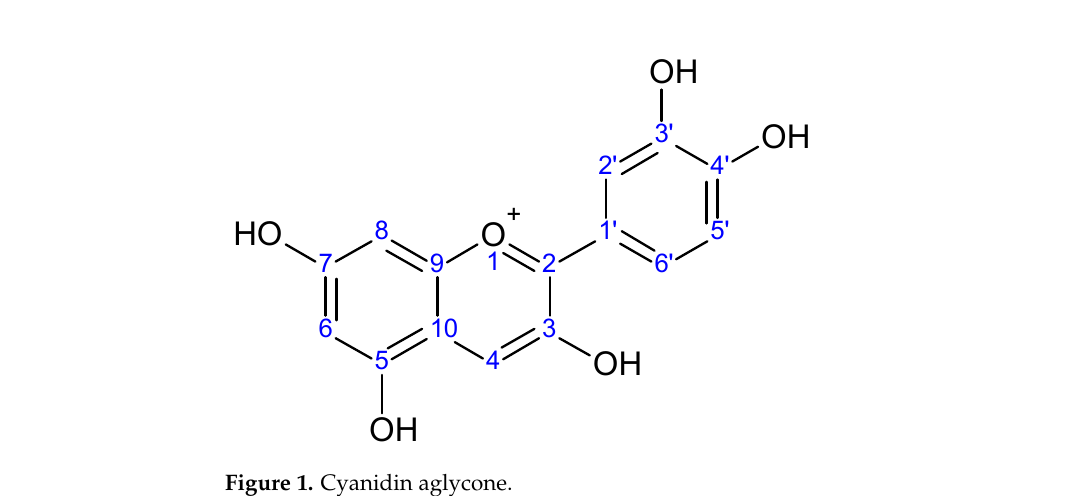
Figure 1. Cyanidin aglycone.